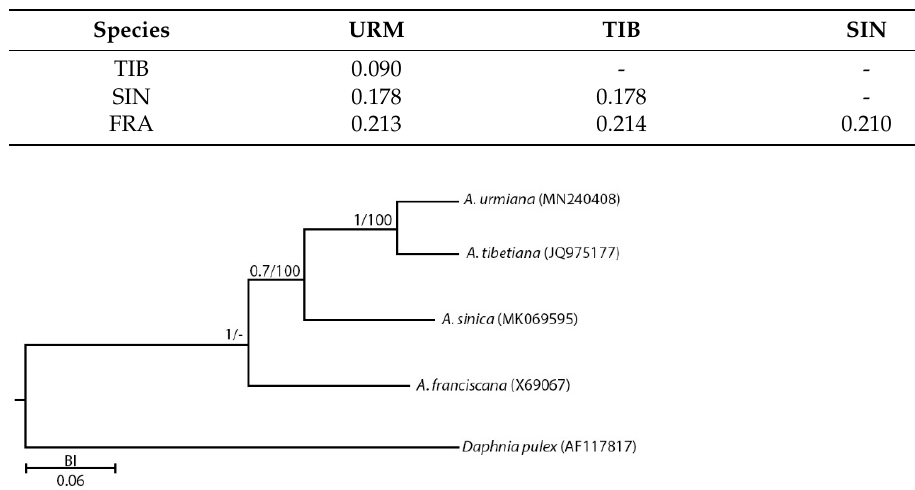
Figure 10. Phylogeny of Artemia using Daphnia as an outgroup. A phylogenetic tree was constructed using PCG+rRNA genes. The maximum-likelihood bootstrap (left) and Bayesian support values (right) are shown for each major node (URM: A. urmiana , TIB: A. tibetiana , SIN: A. sinica , FRA: A. franciscana ).